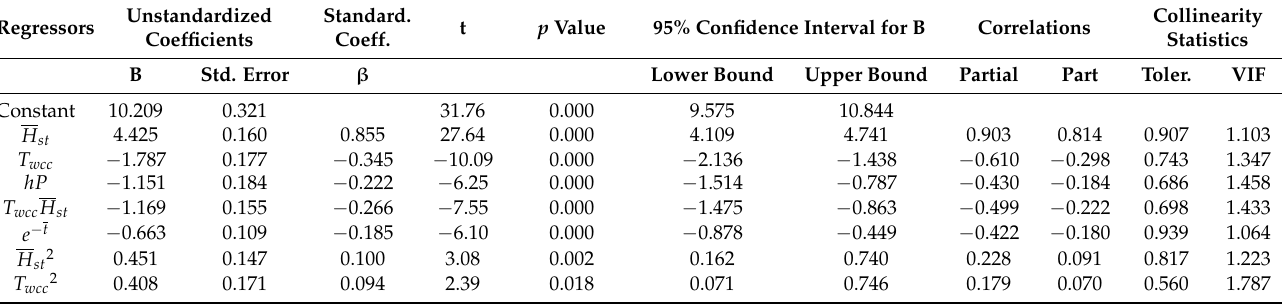
Table 6. Parameters of the final adopted MLR model of HTs total water